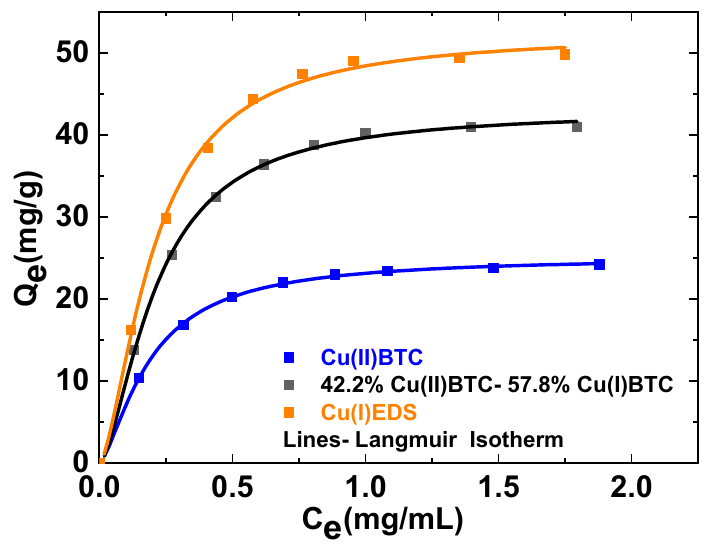
Figure 5. Langmuir adsorption isotherms of toluene for membranes incorporating 7 wt% Cu(II)BTC, Cu(I/II)BTC and Cu(I)EDS MOFs respectively at 298 K after 24 h of membrane equilibration with